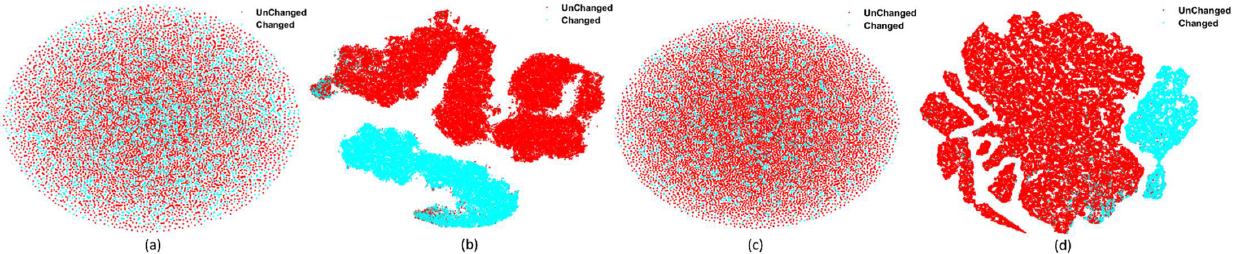
Figure 11. Scatter plots produced by t-SNE of all samples from the Yancheng dataset ( a , b ) and Hermiston dataset ( c , d ). Red circles represent unchanged samples, and blue circles represent changed samples. Yancheng ( a ) original difference tensor, ( b ) features learnt by STT, Hermiston ( c ) original difference tensor, ( d ) features learnt by STT.